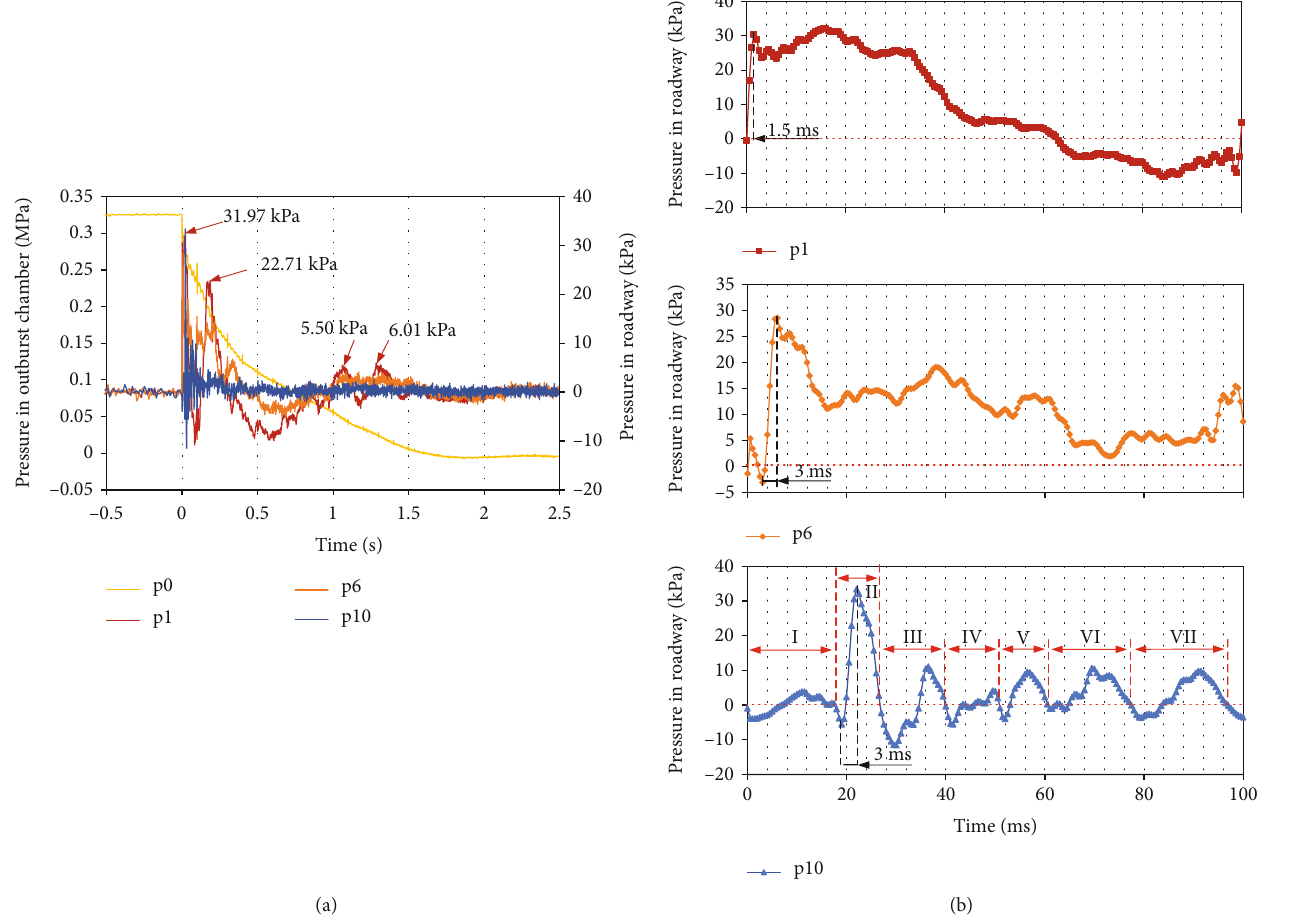
Figure 6: Results of large-size outburst coal-gas fl ow simulation test. (a) Curves of gas pressure of the whole outburst process; (b) curve of pressure in roadway in the fi rst 100ms of